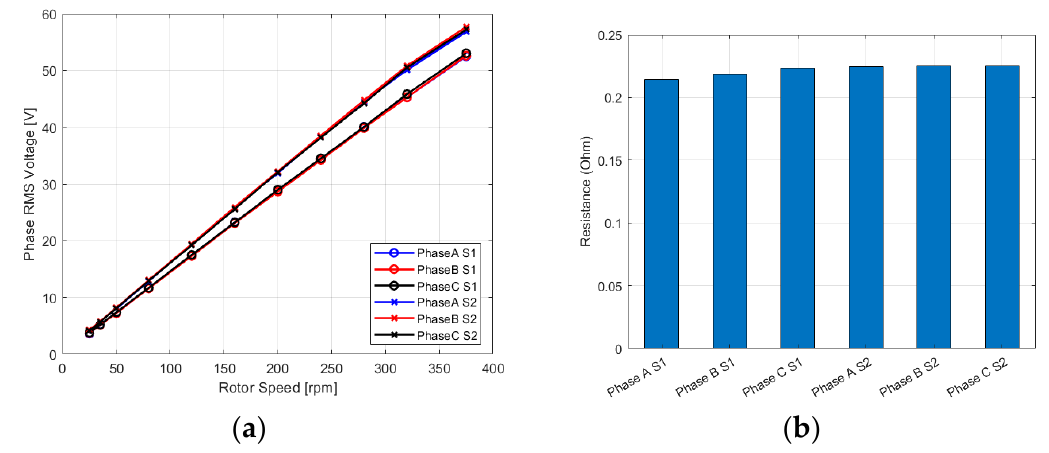
Figure 18. Results from the electric measurements done on the prototype. ( a ) Open circuit tests: the RMS voltage per phase per stator in function of the speed in rpm; ( b ) resistance values per phase per stator.